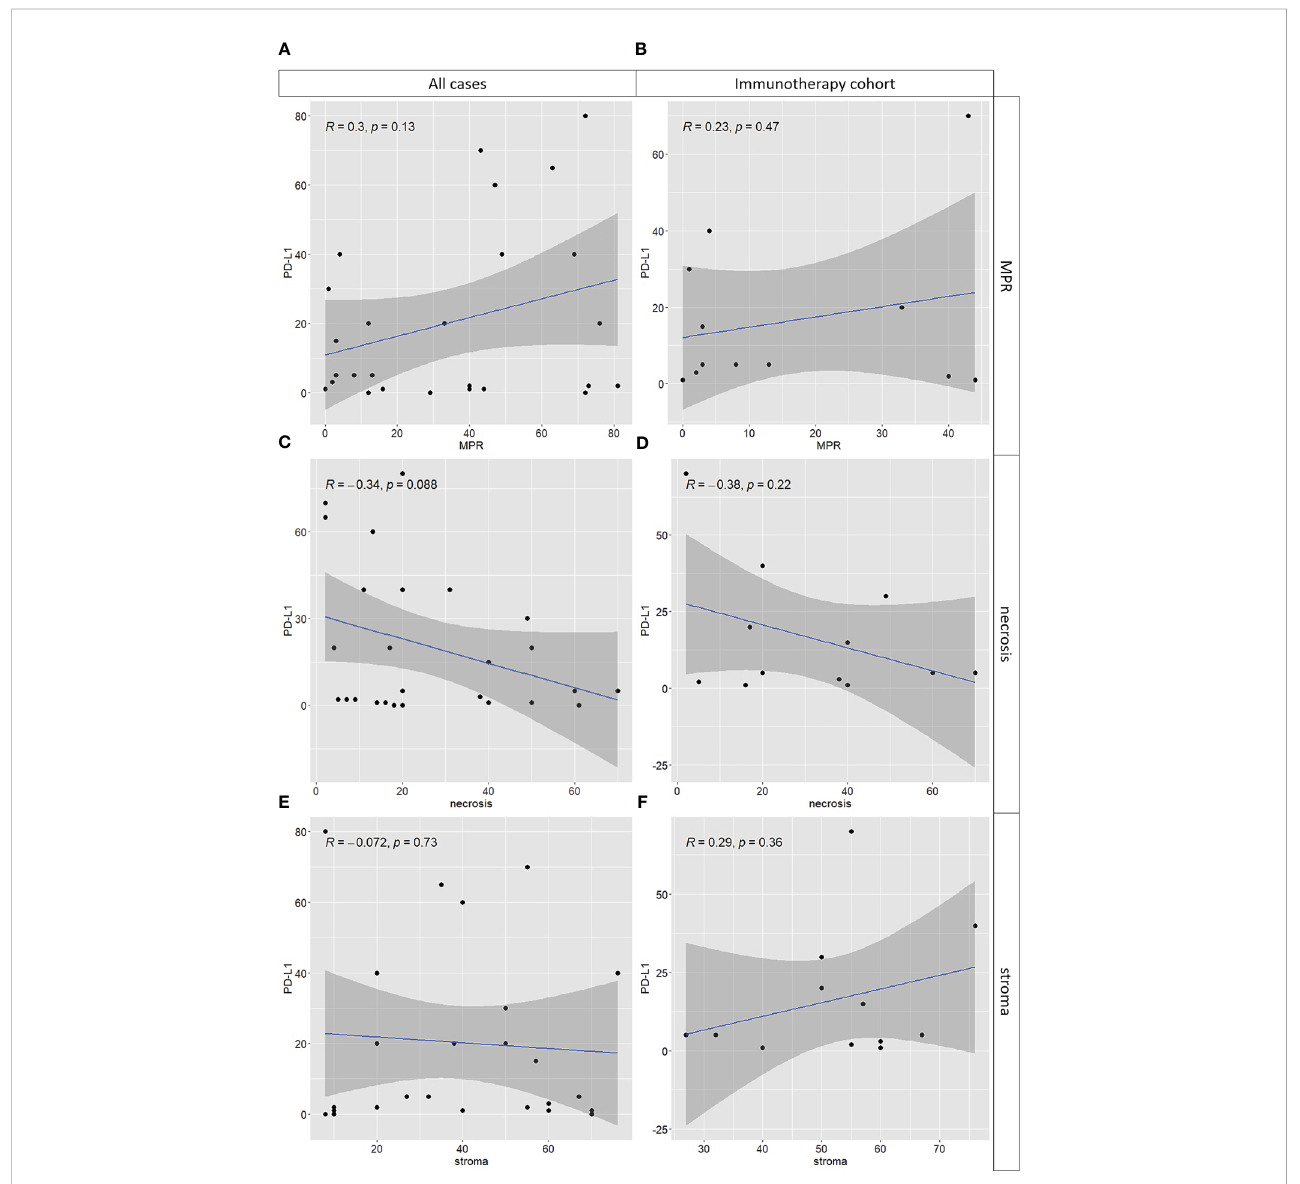
FIGURE 4 Correlations between PD-L1 tumor proportion score in naïve tumor and tumor components after neoadjuvant treatment including major pathological response (MPR), necrosis and stroma (i.e, in fl ammatory cells and fi brosis). On the left (i.e., panels A , C , E ) the entire cohort of cases was used; on the right (i.e., panels B , D , F ) only cases treated with chemo-immunotherapy were used. While for MPR (A, B) and necrosis (C, D) the results are consistent, a mild positive correlation between PD-L1 levels and stroma is observed in the chemo-immunotherapy cohort only (F) , not in the entire cohort (E)